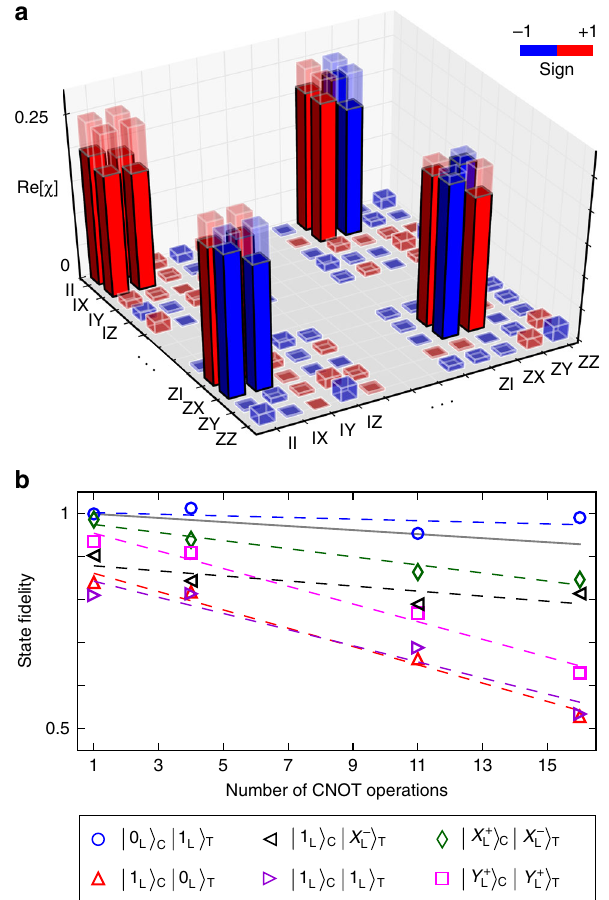
Fig. 4 Characterization of the controlled NOT gate. a Quantum process tomography. The solid (transparent) bars represent the measured (ideal) elements of the process matrix χ . The corresponding process fi delity is F CNOT = (89 ± 2)%. For clarity, only the corners of the process matrix are presented. The full χ -matrix is shown in Supplementary Note 8 for completeness. b State fi delity under repeated gate applications for various input states, chosen to highlight different error mechanisms of the gate (the dashed lines are linear fi ts). The solid gray line depicts the simulated average slope of state fi delity imposed by ancilla decoherence. The state fi delities are calibrated by the value measured for the vacuum state (Supplementary Note 6). The standard errors are derived from bootstrapping, and are equal in size to the symbols